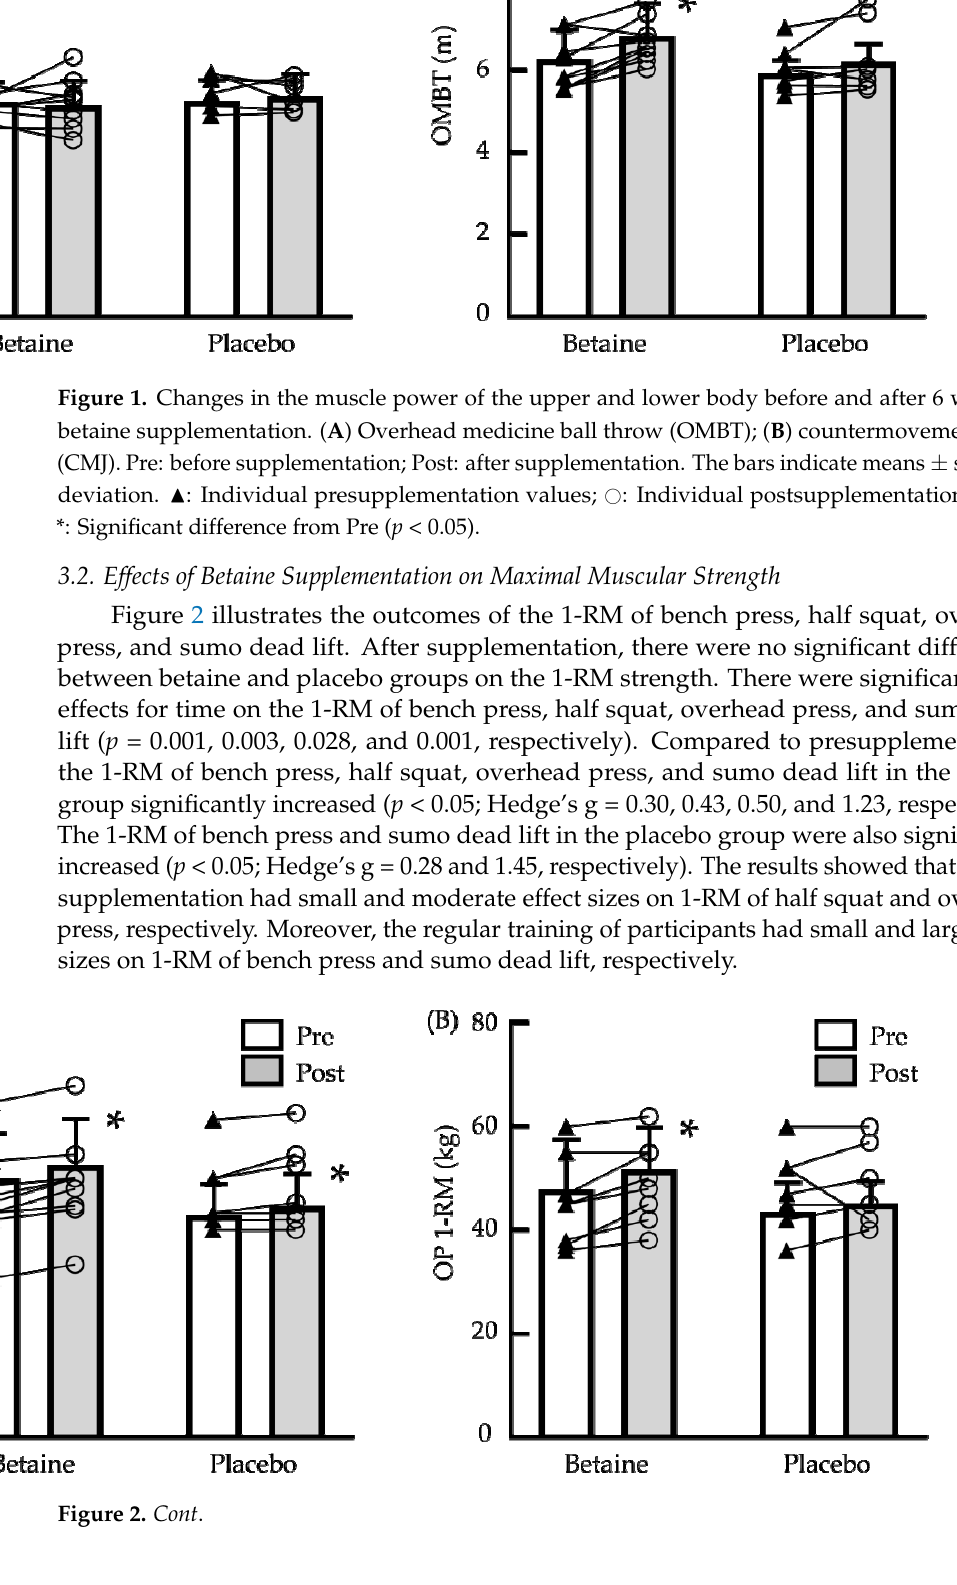
Figure 2. Changes in the one repetition maximum (1-RM) before and after 6 weeks of betaine sup- plementation. ( A ) Bench press (BP); ( B ) overhead press (OP); ( C ) half squat (HS); and ( D ) sumo dead lift (SD). Pre: before supplementation; Post: after supplementation. The bars indicate means ± standard deviation. ▲ : Individual presupplementation values; ○ : individual postsupplementation values; *: significant difference from Pre ( p < 0.05). 3.3. Effects of Betaine Supplementation on Blood Lipid Profile Table 2 illustrates the outcomes of the concentrations of TGs, TC, HDL-C, and LDL-C after 6 weeks of betaine or placebo supplementation. After supplementation, there were no significant differences between betaine and placebo groups on the blood profile. There were significant main effects for time on the concentrations of TC and LDL-C ( p = 0.001 and 0.004, respectively). Compared to pre- supplementation, the TC concentration in the betaine group significantly decreased ( p < 0.05; Hedge’s g = 0.91). Moreover, the concentrations of TC and LDL-C in the placebo group significantly decreased ( p = 0.003 and 0.024; Hedge’s g = 1.17 and 0.87, respective- ly). The results showed that 5 g/day of betaine supplementation in collegiate athletes of Division I during the preparatory period had no negative effect on blood lipid profiles.